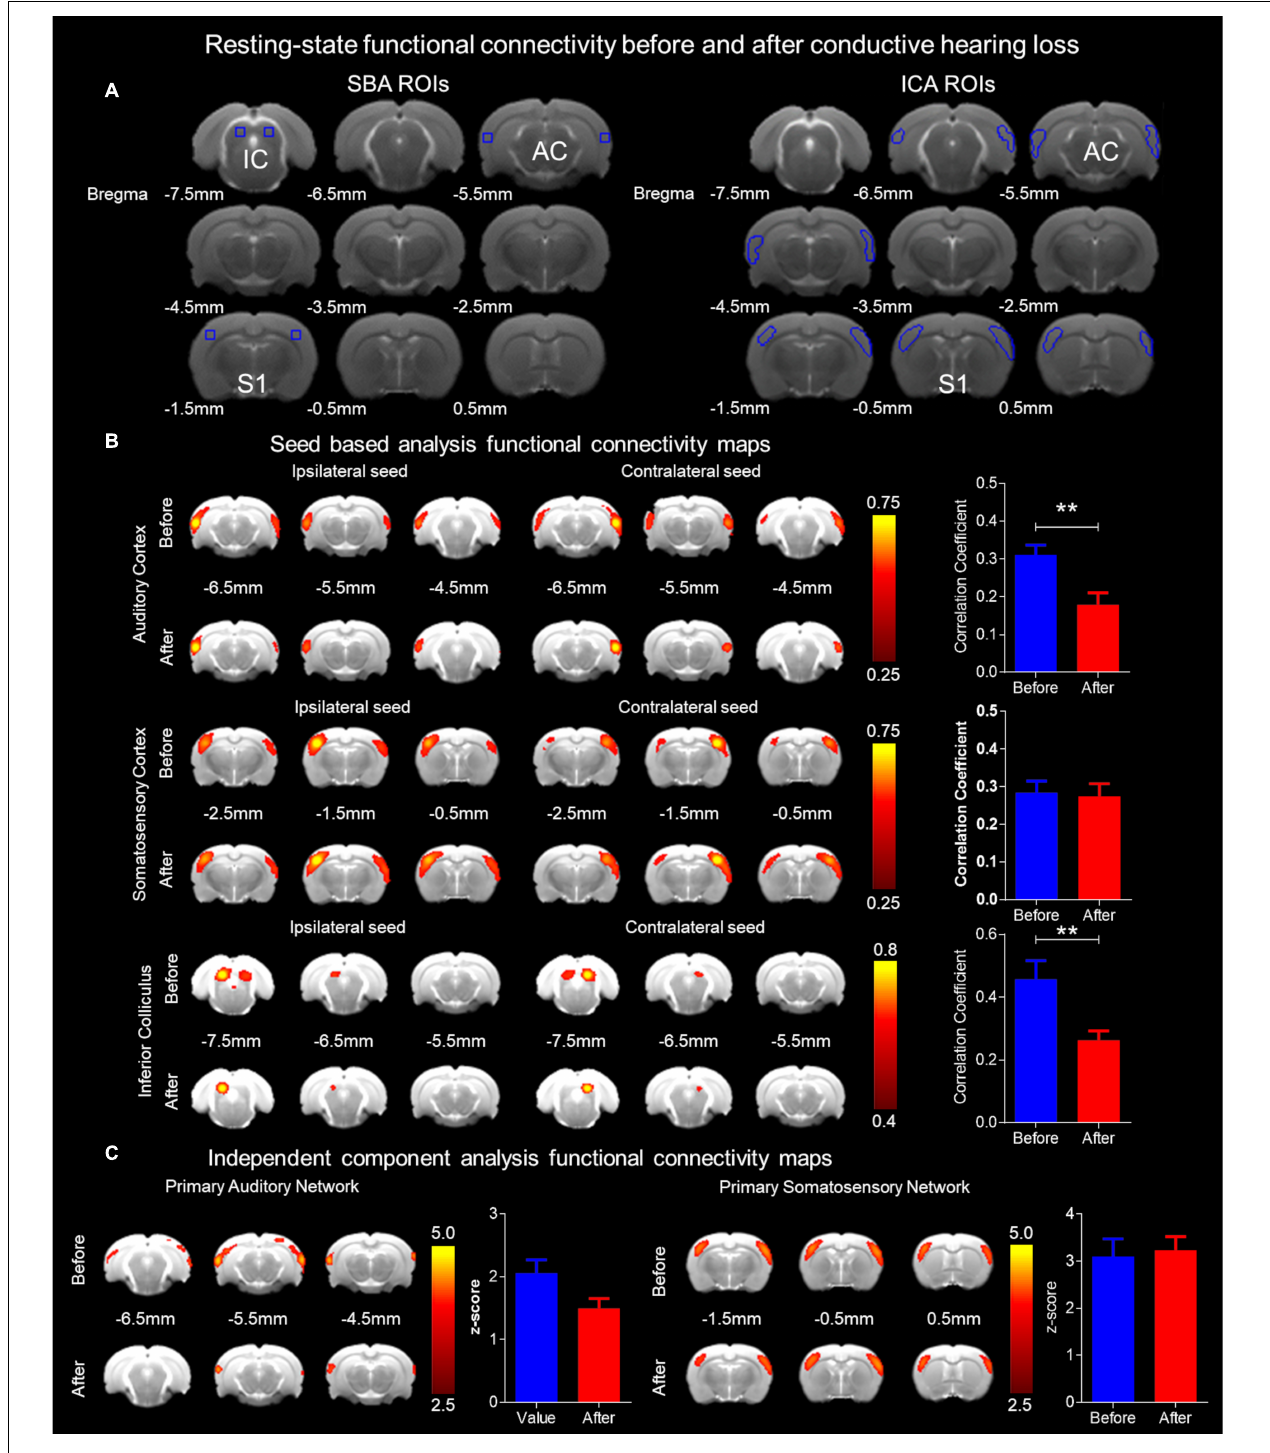
FIGURE 5 | Functional connectivity alterations resulting from conductive hearing loss as assessed by rsfMRI. (A) Seeds used for SBA and masks for ICA were used to delineate ROI for the bilateral auditory cortex, somatosensory cortex, and IC rsfMRI networks. (B) The SBA rsfMRI connectivity was significantly decreased in the auditory cortex and IC after CHL ( p < 0.01), however, remaining unchanged in the somatosensory cortex. The bar plots indicate the correlation coefficient before (blue) and after (red) CHL, demonstrating a decrease of 42.27% and 42.50% for the auditory cortex and IC, respectively. (C) The ICA rsfMRI connectivity was decreased in the auditory cortex after CHL, and was unchanged in the somatosensory cortex. The bar plots indicate the z-score before (blue) and after (red) CHL, demonstrating a decrease of 27.11% for the auditory cortex. Both SBA and ICA demonstrate rsfMRI networks decrease after CHL.